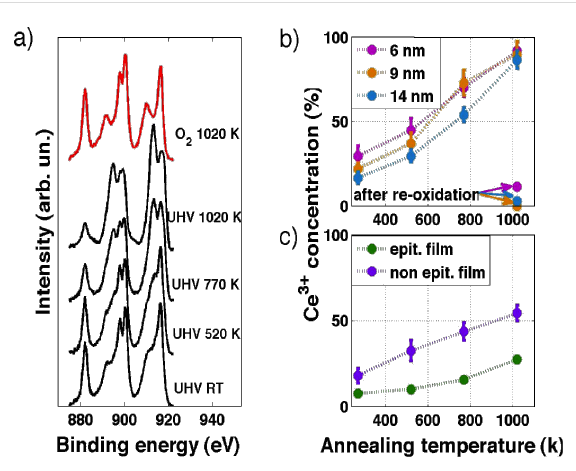
Figure 5: (a) Ce 3d XPS spectra for a complete reduction (black curves) and oxidation (red curve) cycle. (b) Intensity of the Ce 3+ component at different annealing temperature and after re-oxidation on NPs of diameter of 6 nm (pink dots), 9 nm (orange dots), and 14 nm (blue dots), and (c) on the ultra-thin epitaxial (green dots) and non- epitaxial (violet dots) ceria film.